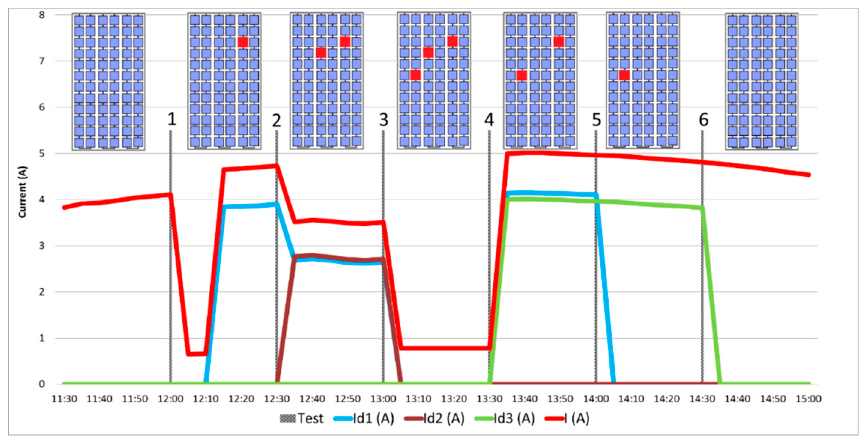
Figure 8. Total output PV module and bypass diode currents measured in test 2.